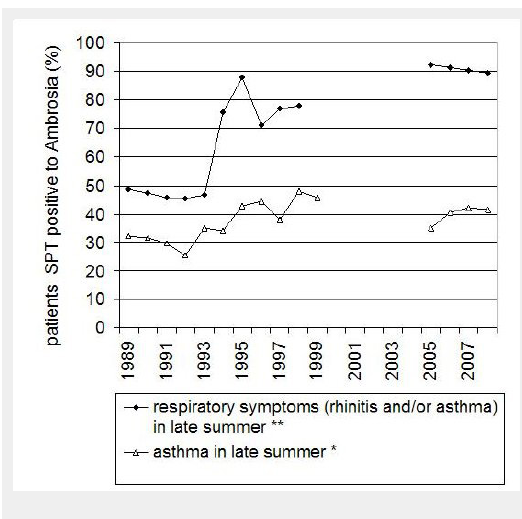
Increase of Ambrosia allergy among Ambrosia SPT positive patients in Legnano. The significance of the trends was calculated using the Mann-Kendall trend test: p <0.05*; p